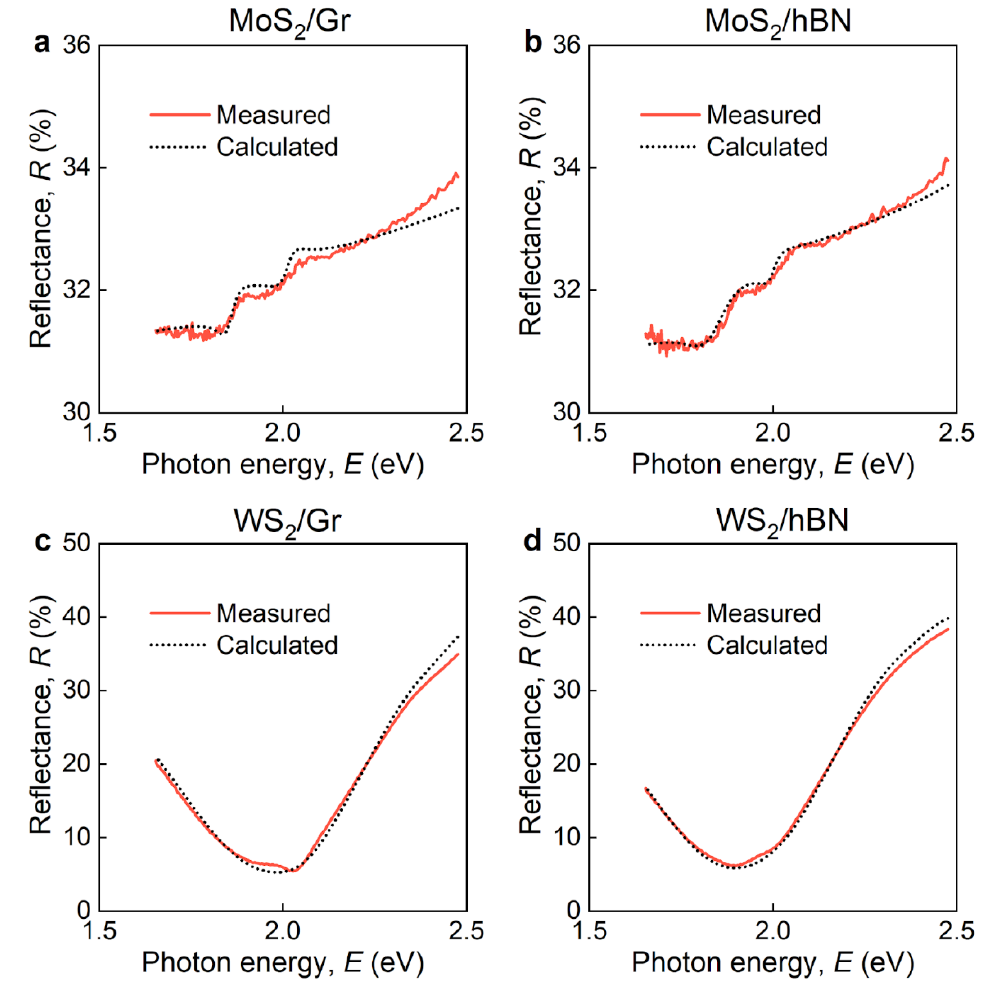
Figure 5. Measured and calculated reflectance spectra for ( a ) MoS 2 /Gr, ( b ) MoS 2 /hBN, ( c ) WS 2 /Gr, and ( d ) WS 2 /hBN heterostructures.